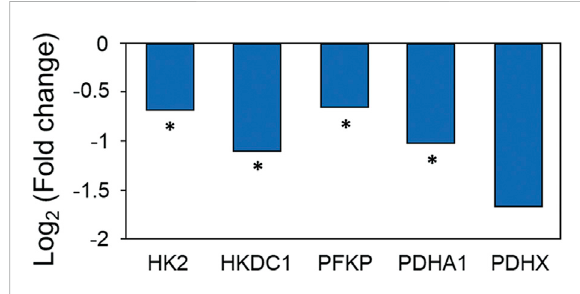
FIGURE 9 Proteomic changes in energy metabolism in Caco-2 cells uponcoculturewith C.dif fi cile .Proteomicanalysiswasperformed in triplicate. HK2: hexokinase 2, HKDC1, hexokinase domain containing 1; PFKP, phosphofructokinase; PDHA1, pyruvate dehydrogenase E1 component subunit alpha; PDHX,